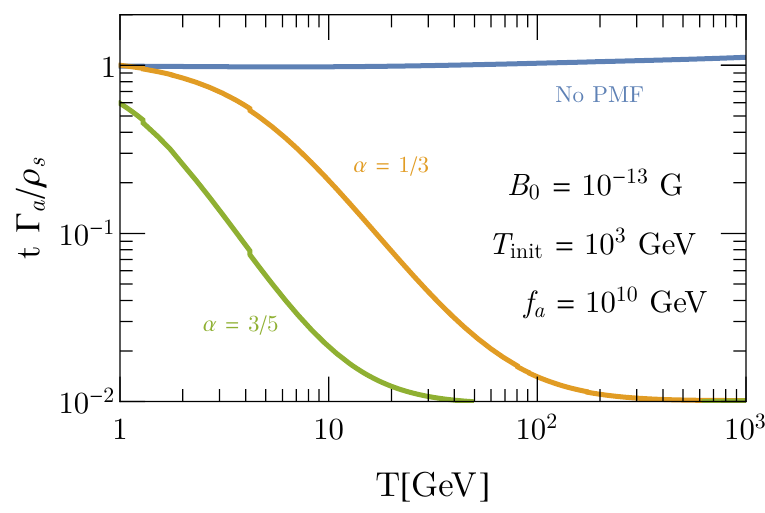
Figure 4 . Energy emission rate from axion strings into the axion field, normalized by the approx- imation ρ . In the friction dominated regime, this ratio becomes unity. In the stretching regime, s /t the actual rate is suppressed by up to 10 − 2 due to the low reconnection